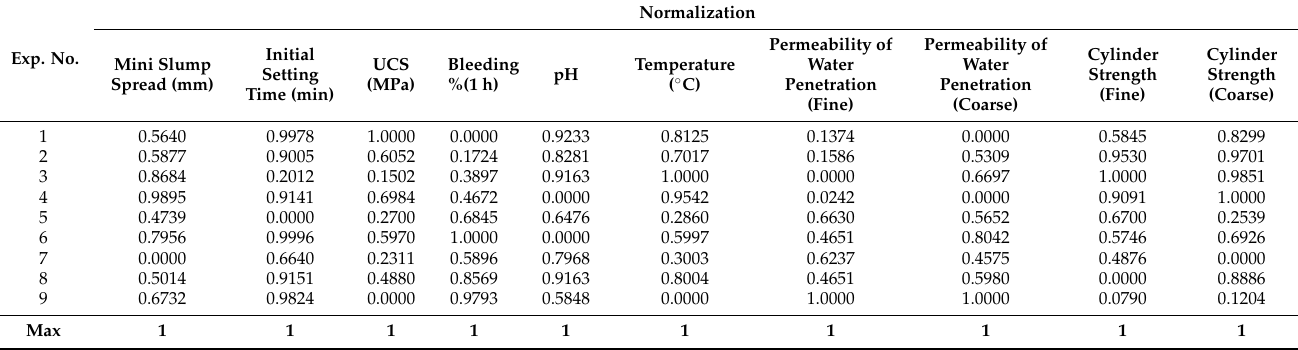
Table 9. Grey relational analysis for data